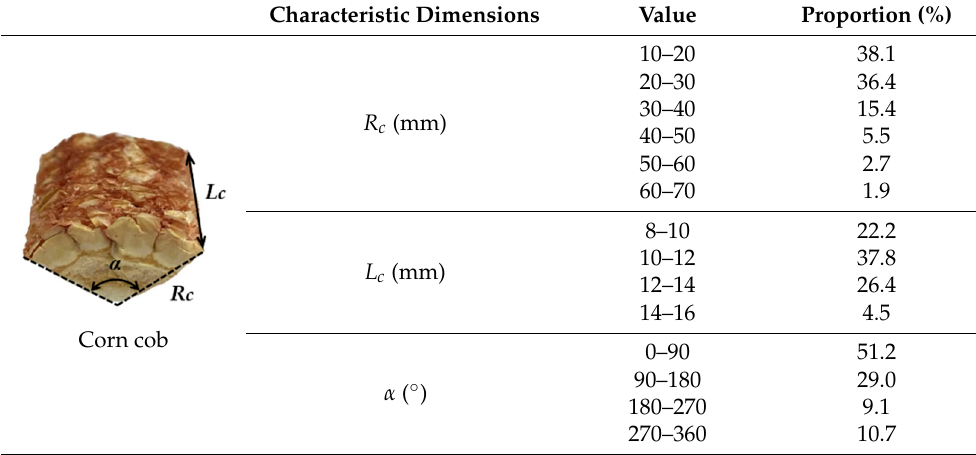
Table 5. Characteristic dimensions of corn cobs.